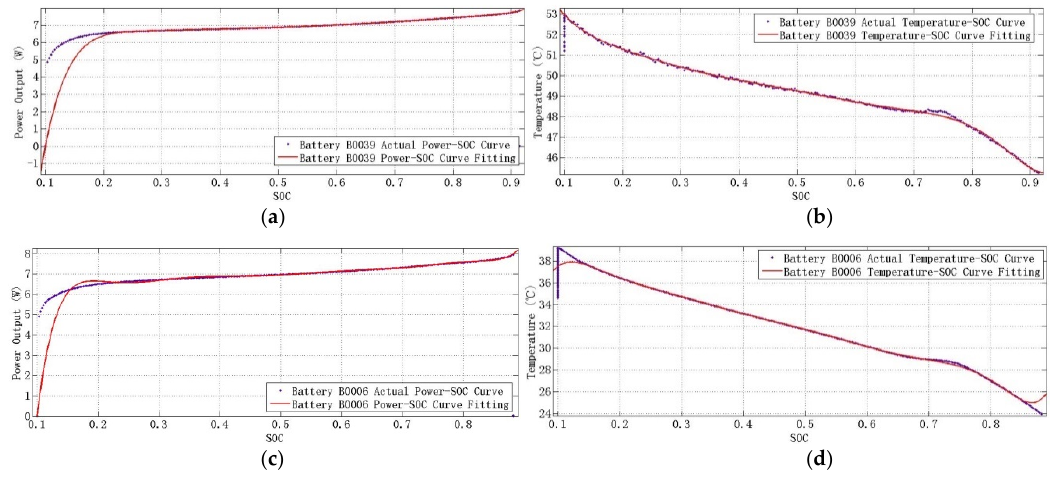
Figure 2. Battery actual characteristic curve fitting. ( a ) is Battery B0039 actual power ‐ SOC curve fitting; ( b ) is Battery B0039 actual temperature ‐ SOC curve fitting; ( c ) is Battery B0006 actual power ‐ SOC curve fitting and ( d ) is Battery B0006 actual temperature ‐ SOC curve fitting.